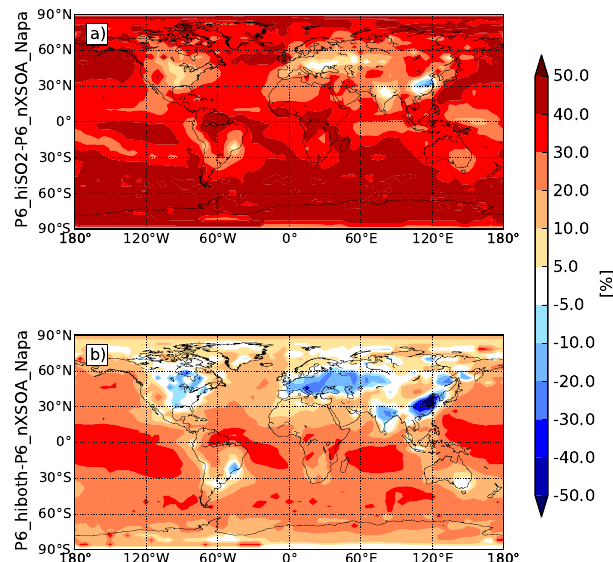
Figure 9. Relative change in the absolute number of newly formed sub-grid sulphate particles (including increases due to increases in SO 2 emissions) from the P6_nXSOA_Napa simulation to the (a) P6_hiSO2 and (b) P6_hiboth simulations, as calculated offline by the P6 Gradient